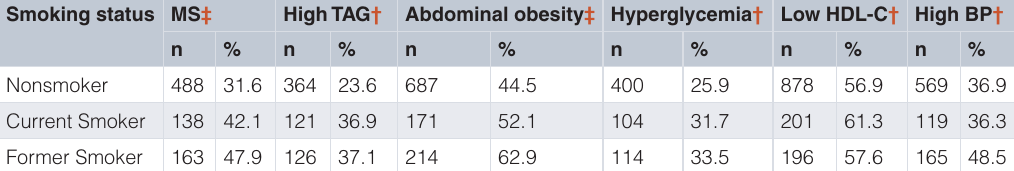
Venezuela.Table 2. Smoking habit in accordance with MS and its components. Maracaibo,